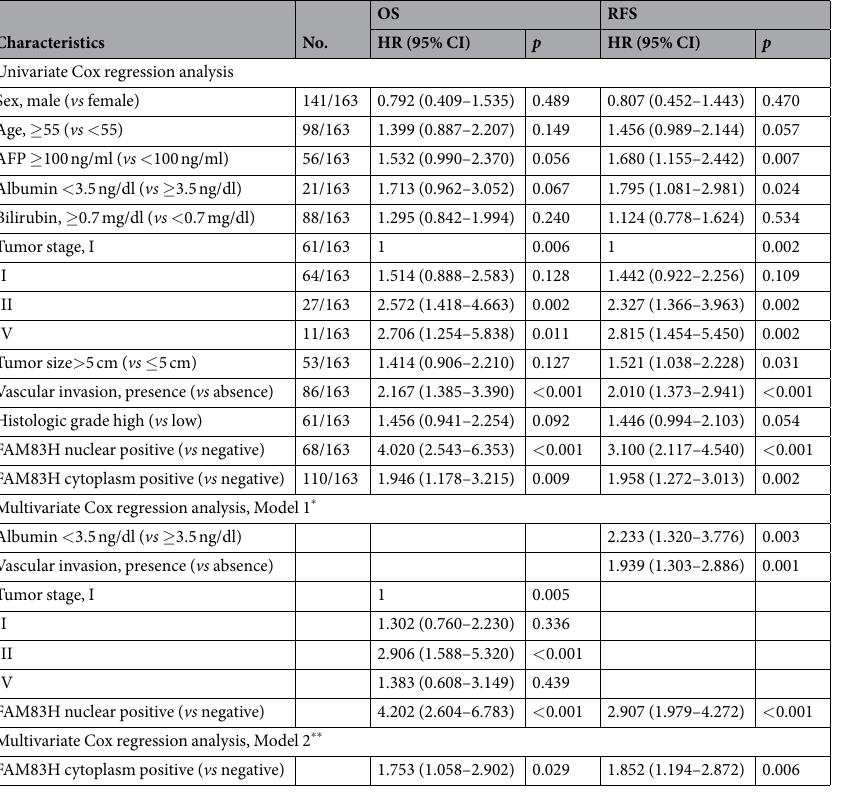
Table 2. Univariate and multivariate Cox regression analysis for overall survival and relapse-free survival in 163 hepatocellular carcinoma patients. HBV, hepatitis B virus; HCV, hepatitis C virus; AFP, α -fetoprotein; HR, hazard ratio. * Variables considered in multivariate analysis Model 1 were tumor stage, tumor size, vascular invasion, α -fetoprotein level, albumin level, nuclear expression of FAM83H, and cytoplasmic expression of FAM83H. ** Variables considered in multivariate analysis Model 2 were tumor stage, tumor size, vascular invasion, α -fetoprotein level, albumin level, and cytoplasmic expression of